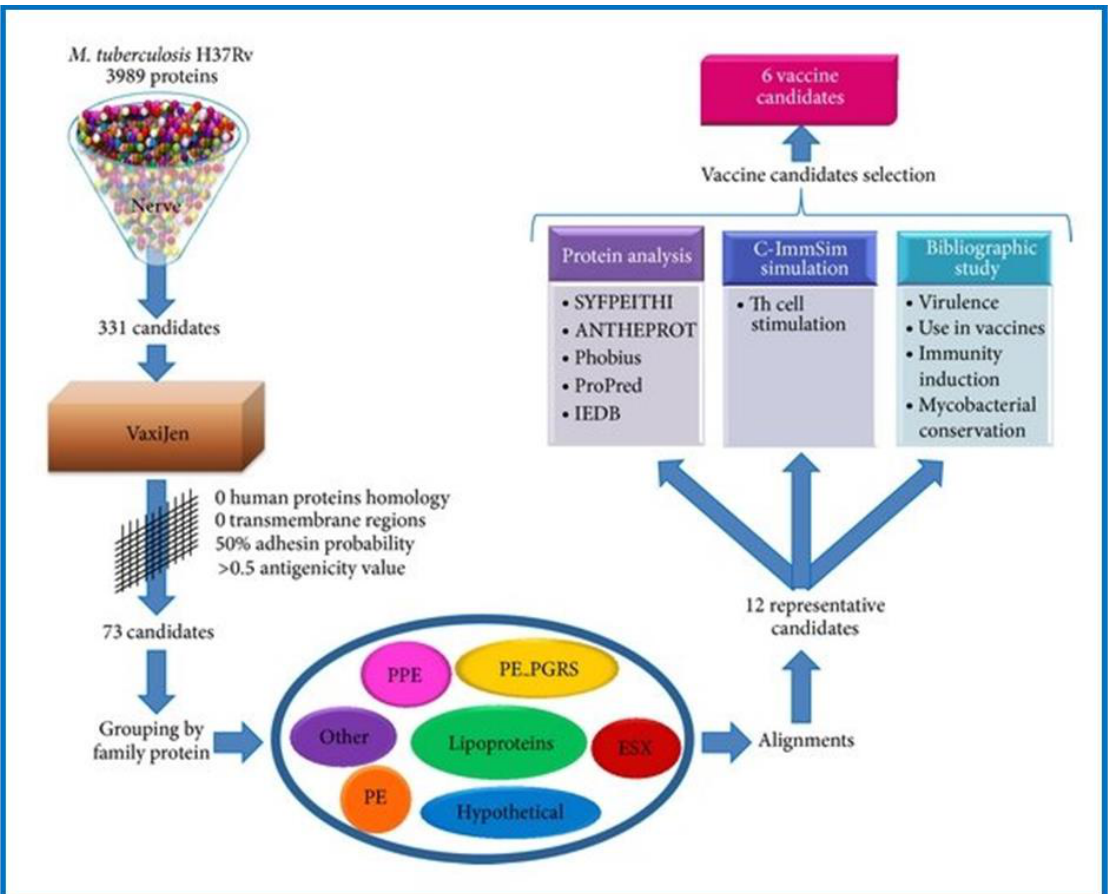
Figure 3. This flow diagram represents the workflow of the study conducted by Monterrubio-López and Ribas-Aparicio for the identification of promising novel vaccine candidates against M . tuberculosis through reverse vaccinology. Reprinted from Monterrubio-López and Ribas-Aparicio, 2015 [106]. Table 4. Post genomics techniques for vaccines against intracellular bacterial infections, along with the current state of each vaccine ’ s development. Data were collected from Bambini and Rappuoli (2009) [93].